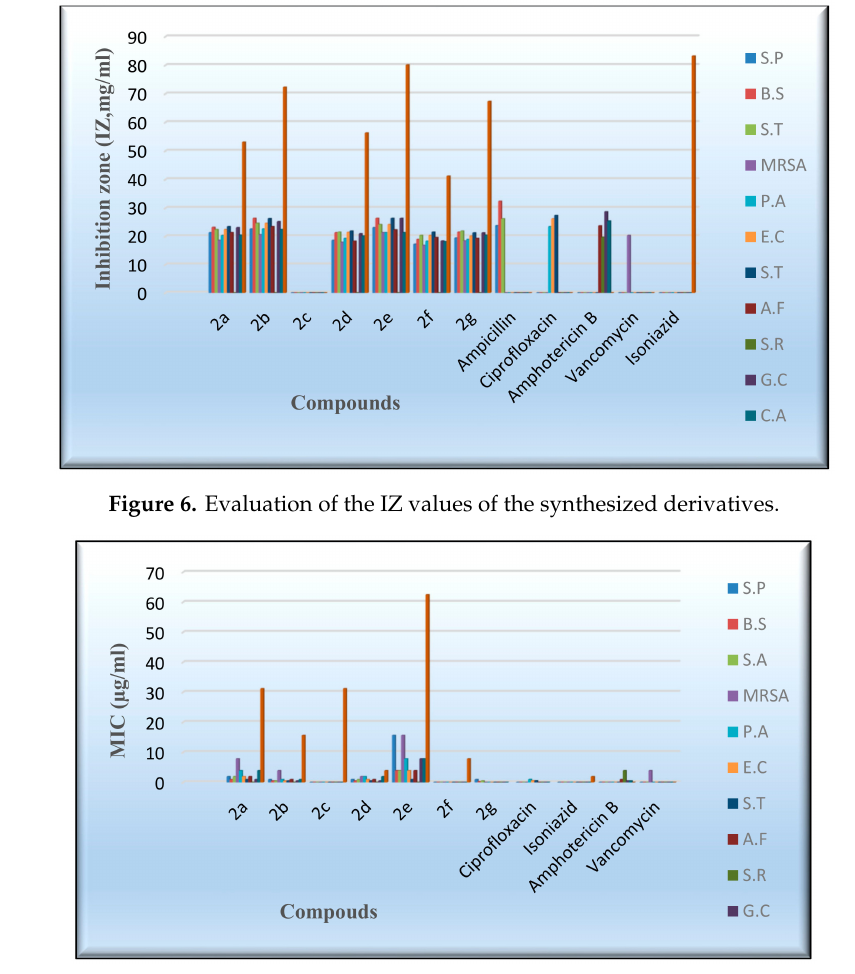
Figure 7. Evaluation of the MIC values of the desired